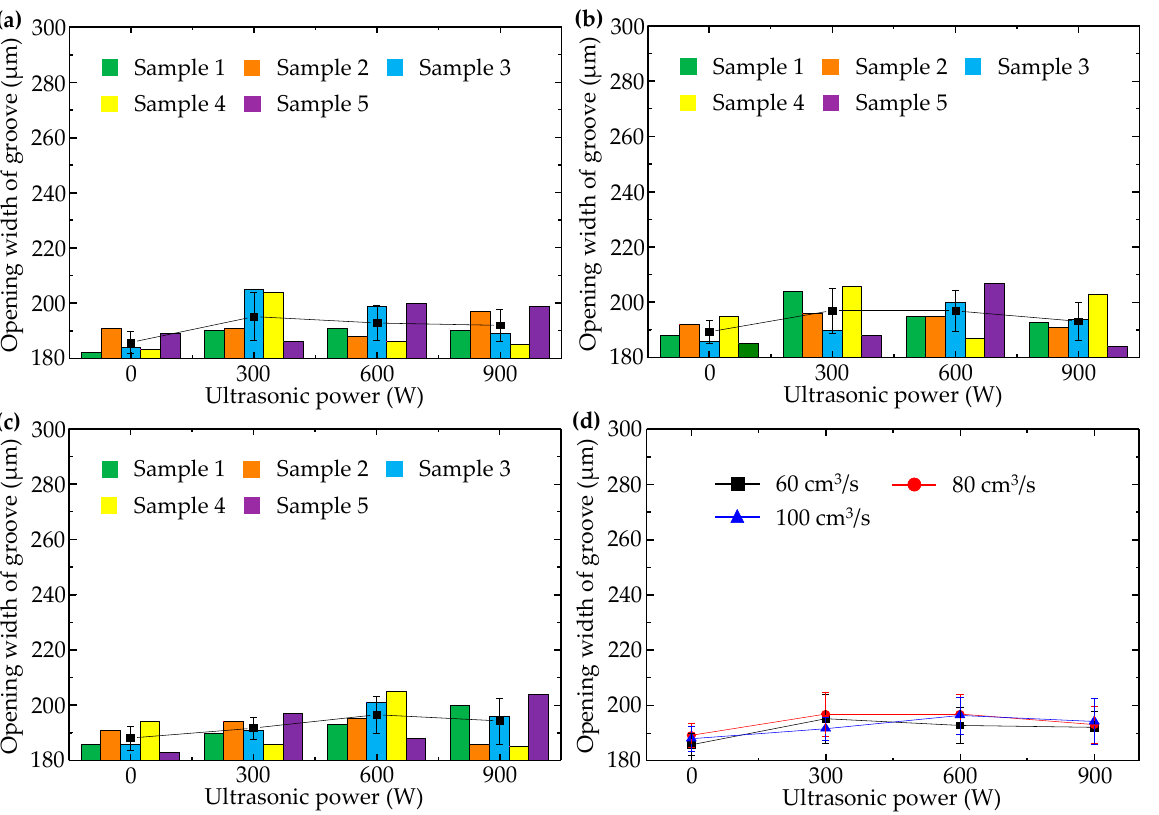
Figure 7. Variation of opening width of the longitudinal micro groove with ultrasonic power when injection pressure was 90 MPa and injection speeds were ( a ) 60 cm 3 /s, ( b ) 80 cm 3 /s, and ( c ) 100 cm 3 /s. ( d ) Comparison of the average values of each group.